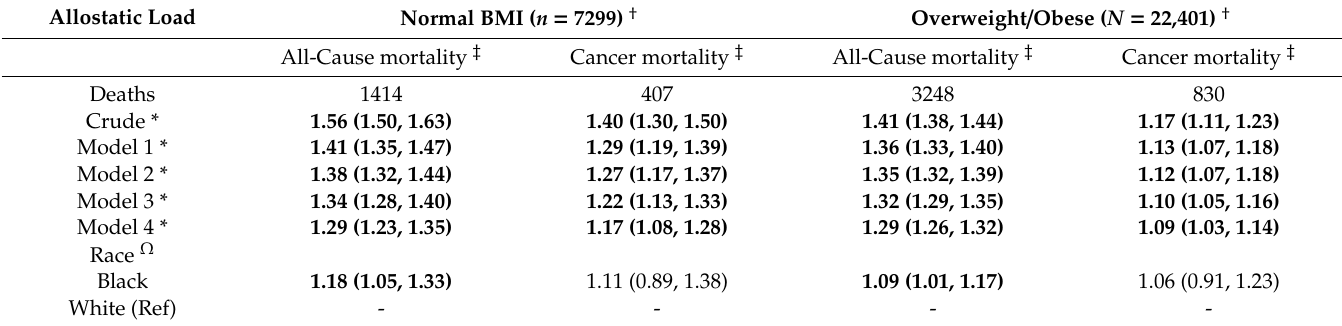
Table 4. Multivariable Adjusted Cox Proportional Hazards Models * for the Association †‡ of Allostatic Load Score with All-Cause and Cancer-Specific Mortality in REGARDS Stratified by BMI ( N =